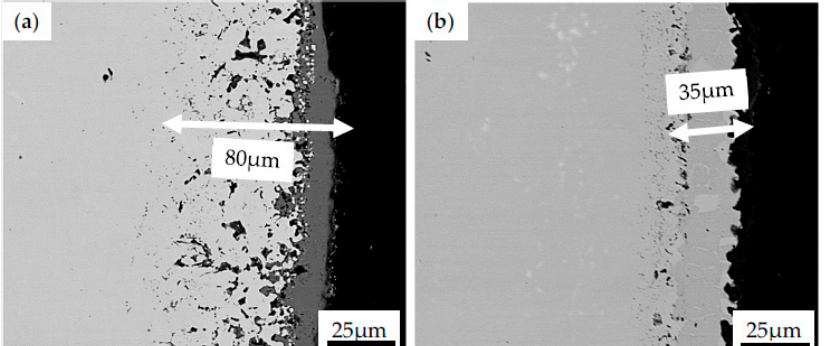
Figure 7. The surface evolution of Inconel 740 in the as-received state ( a ) and with the NiAl coating obtained during CVD process ( b ) after exposure to high temperature at 1000 °C for 100 h.